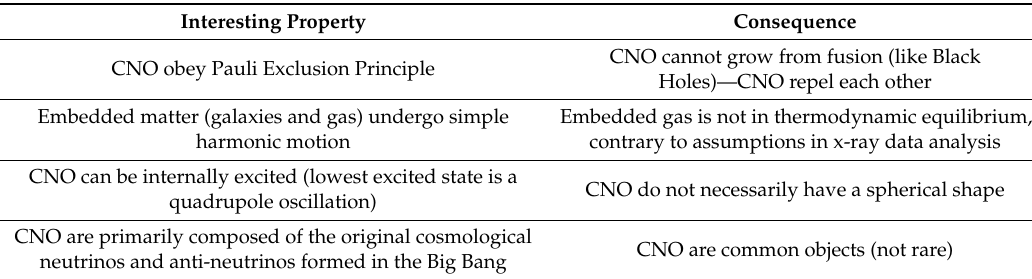
Table 2. Interesting CNO